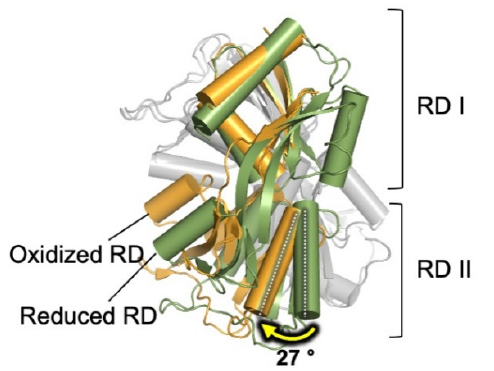
Figure 4. Reorganization of the dimeric assembly of the S. typhimurium RD upon methionine oxidation. Two RD protomers within the dimer in the oxidized form (orange; PDB ID: 5YEZ) have a relative rotation of ∼ 30° in RD II compared with that in the reduced state (green; PDB ID: 5YDO). The rotation of α 8 in RD II caused by oxidation is indicated. The subunit, which is used as a reference for the superimposition, on the backside of the dimer is colored in gray for clarity.